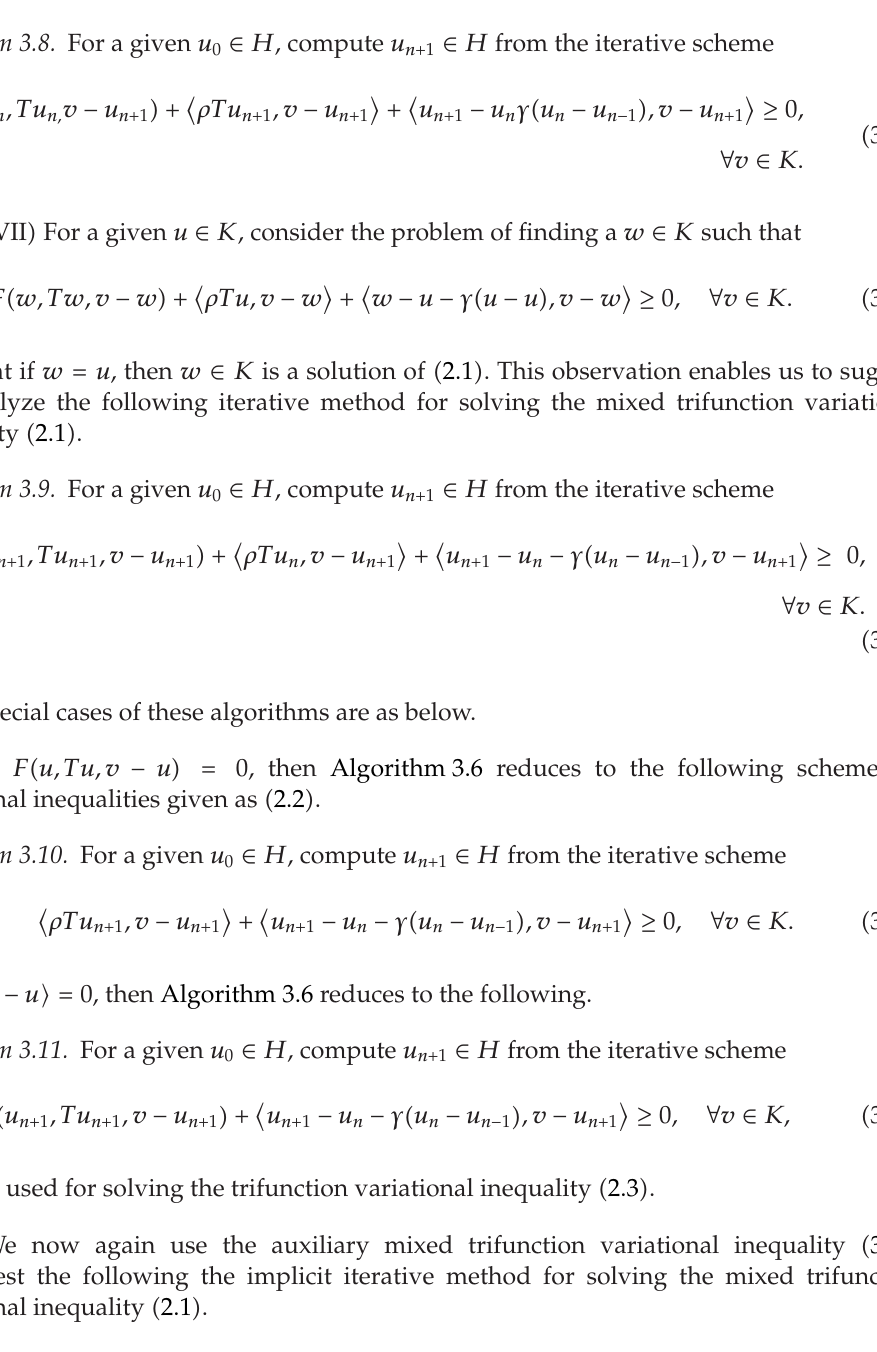
Algorithm 3.12. For a given u 0 ∈ H , compute u n (cid:7) 1 ∈ H from the iterative